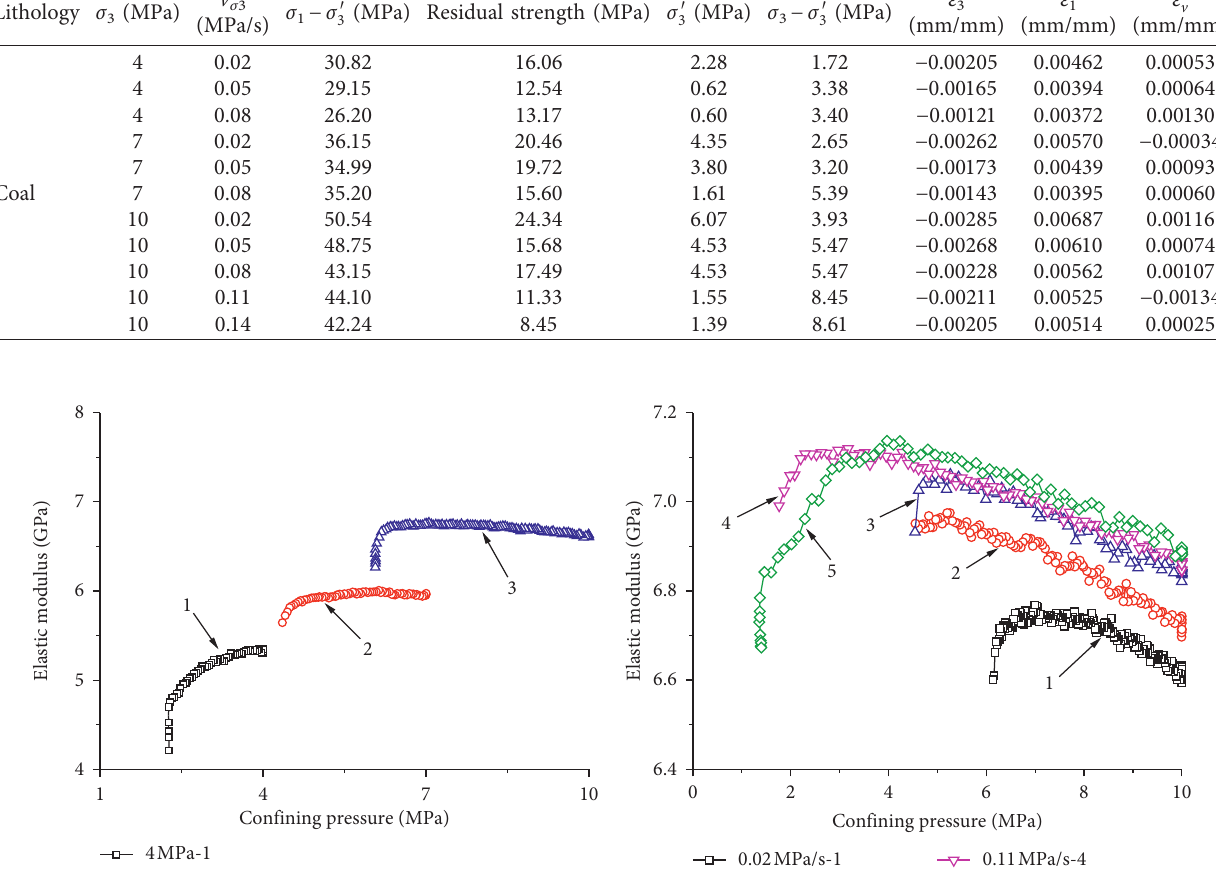
Table 2: Test data of different initial unloading confining pressure and confining pressure unloading rates. Lithology σ 3 (MPa)